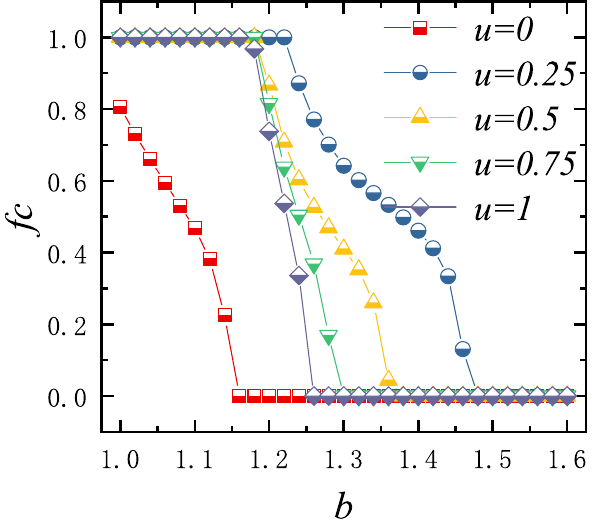
Figure 1. The stationary fraction of cooperators as a function of b for u = 0 , 0.25, 0.5, 0.75 and 1. Results obtained on interdependent lattice with L = 200 and α = 0.5